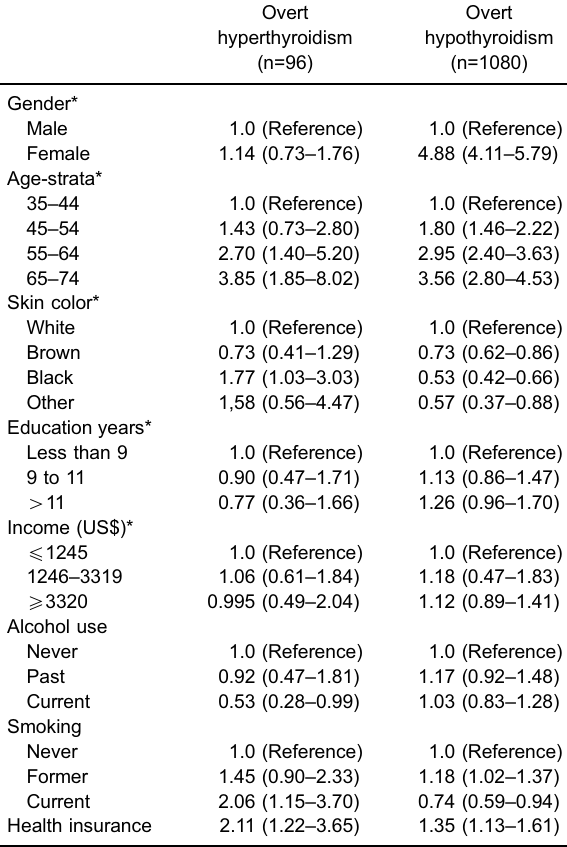
*In multivariate adjustment, each variable in the table was adjusted for all other variables presented in the table except itself. Age was included in the model as a continuous variable except in